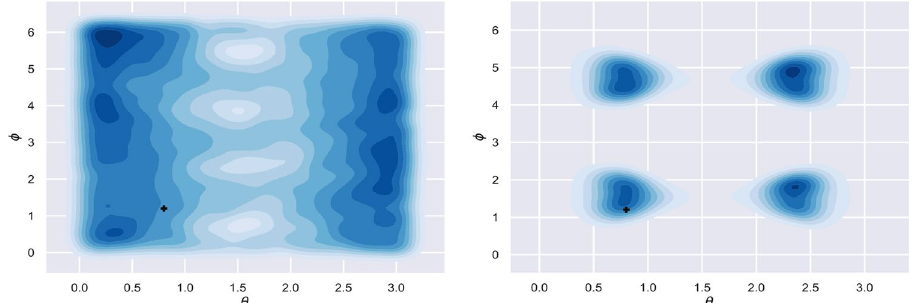
Figure 4. Simulated probability density distributions for position angles { θ , φ } . Left panel: the traditional L-shaped interferometer. Right panel: the 3-D interferometer. The true values ( θ = 0.8, φ = 1.2 ) are marked with a cross, and the outer contour shows the 95% confidence